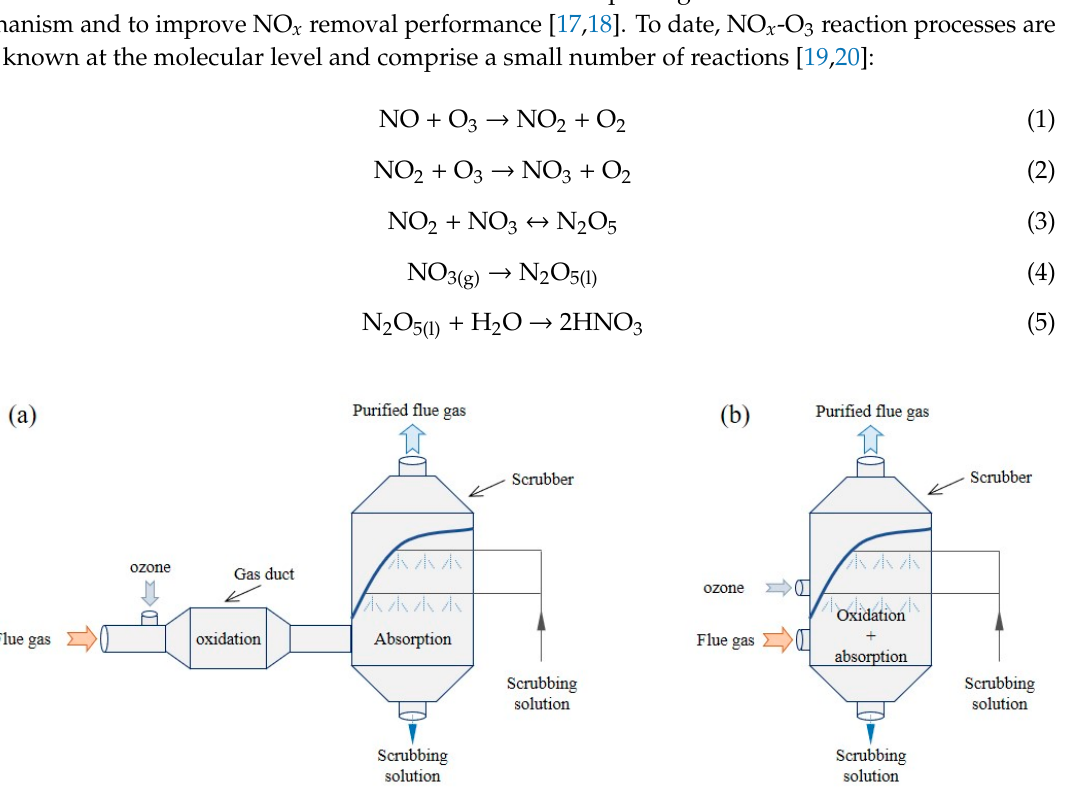
Figure 1. The process diagrams of ozone oxidation denitrification processes: ( a ) traditional two-stage method and ( b ) one-stage method.